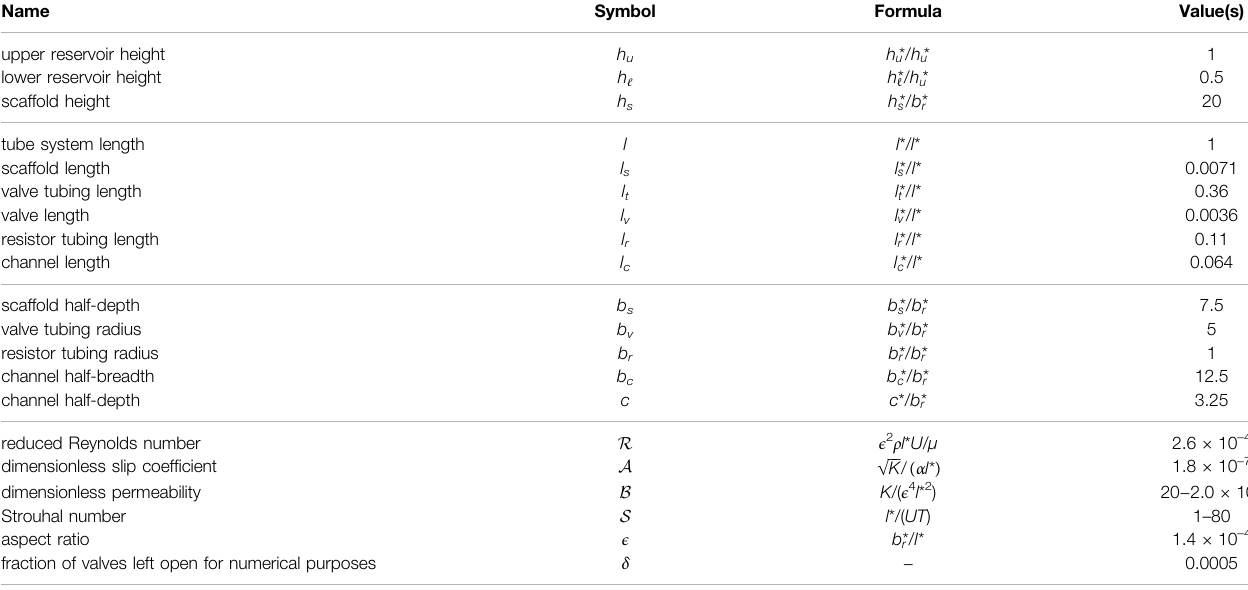
TABLE 2 | Dimensionless parameters corresponding to the bioreactor geometry of Shepherd et al. (2018), given to 2 s.f. Name